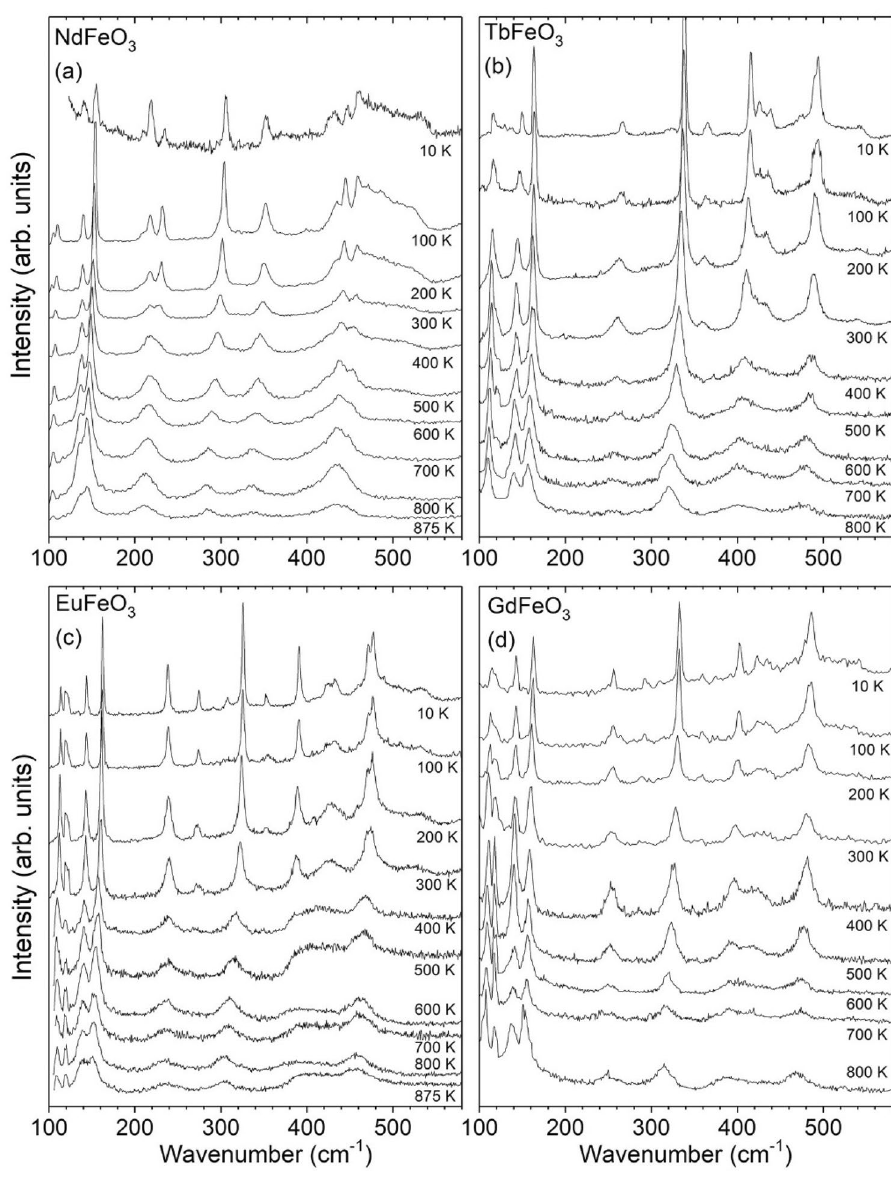
Figure 5. Representative unpolarized Raman spectra of ( a ) NdFeO 3 , ( b ) TbFeO 3 , ( c ) EuFeO 3 and ( d ) GdFeO 3 , recorded at different fixed